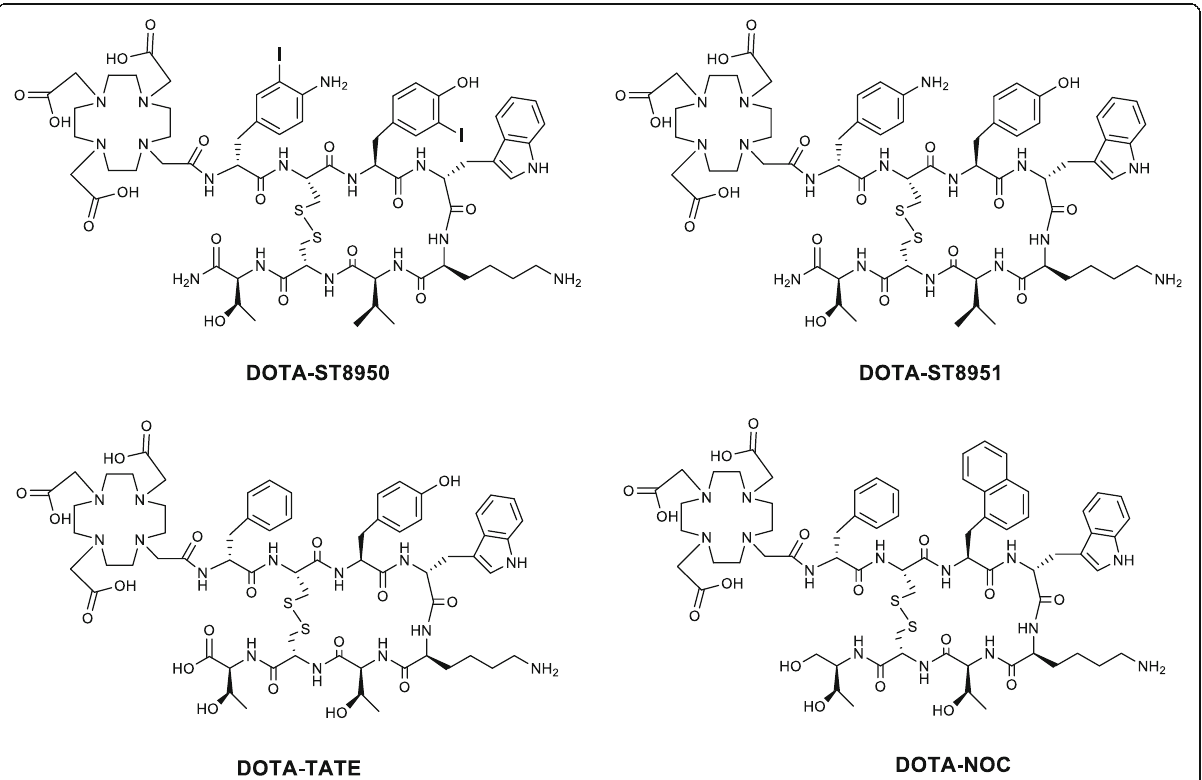
Fig. 1 The structural formulae of the four DOTA-conjugated somatostatin analogs (DOTA-ST8950: DOTA-(4-amino-3-iodo)- D -Phe-c[Cys-(3-iodo)- Tyr- D -Trp-Lys-Val-Cys]-Thr-NH 2 , DOTA-ST8951: DOTA-(4-amino)- D -Phe-c[Cys-Tyr- D -Trp-Lys-Val-Cys]-Thr-NH 2 , DOTA-NOC: DOTA- D -Phe-c[Cys-1-NaI- D - Trp-Lys-Thr-Cys]Thr(ol) and DOTA-TATE: DOTA- D -Phe-c[Cys-Tyr- D